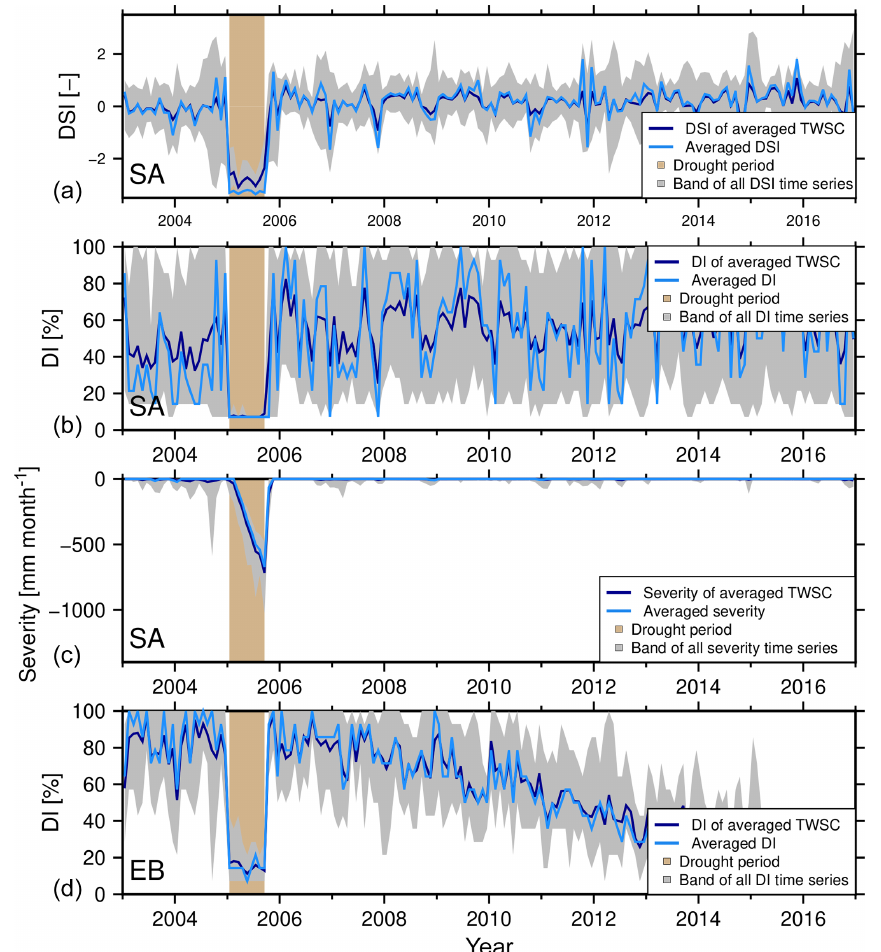
Figure 9. DSI and DI average in southern Africa (SA; a, b ), severity average for the Thomas method (SA; c ), and DI average in eastern Brazil (EB, d ) by applying two different methods: the average of the indicators for all grids (light blue) and the indicators of averaged TWSC (dark blue). The grey shaded area represents the bandwidth for all grids. Light brown shows the synthetic constructed drought